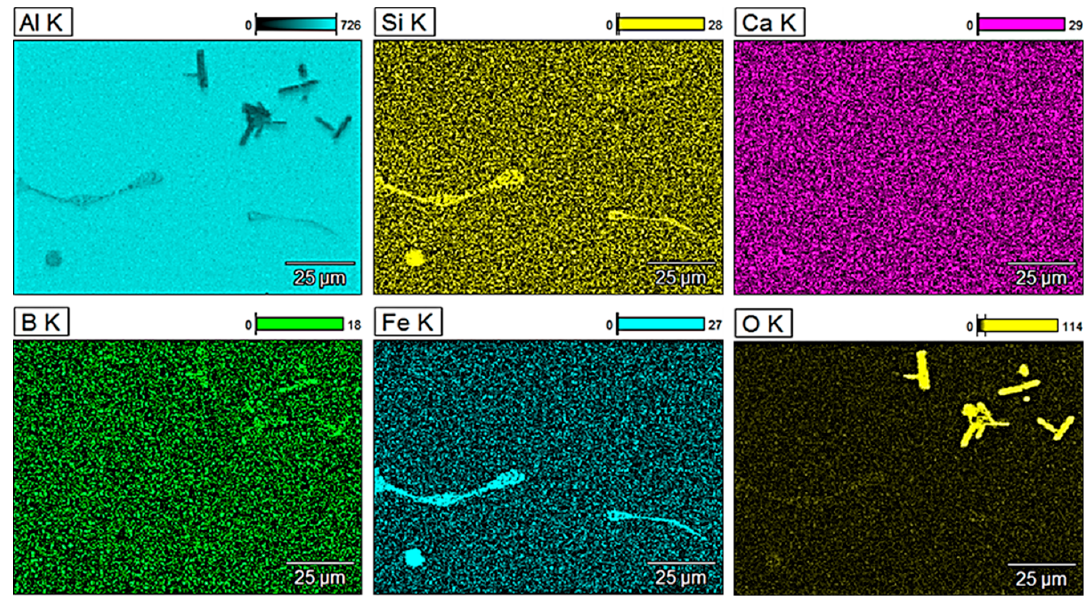
Figure 6. EDX mapping of EN AW 1370 with 5 wt.% of GF reinforcement (metallurgical synthesis).